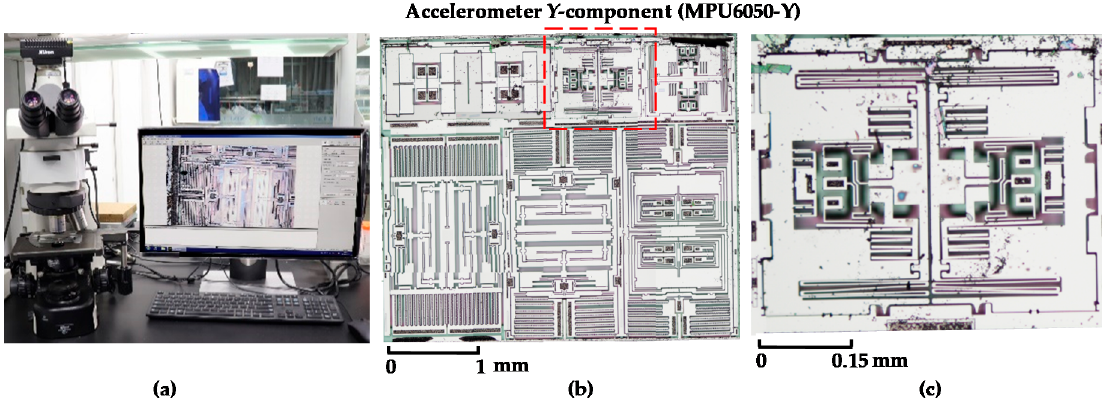
Figure 4. ( a ) Nikon microscope for taking the micrograph of sensor layer; ( b ) micrograph of sensor layer; ( c ) partially enlarged micrograph of MPU6050-Y.